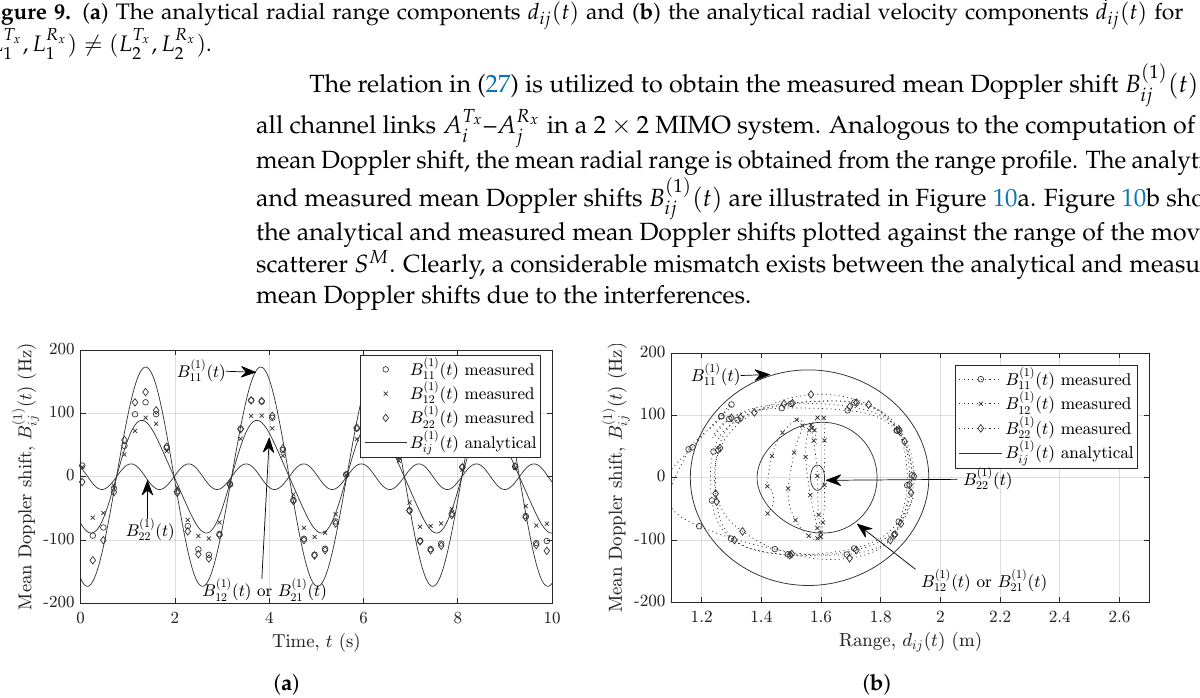
Figure 10. ( a ) The measured mean Doppler shift B d ij ( t ) , where the MIMO radar undergoes cross-channel